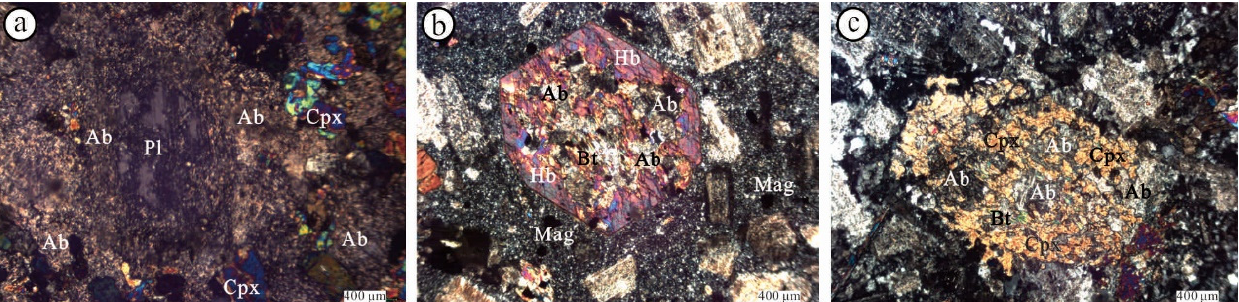
Figure 5. Petrographic features of plutonic rocks of the Jinling pluton. ( a ) Intensely albitized diorites show the replacement of plagioclase by albite. ( b , c ) Small albite and biotite grains have partially replaced hornblende and pyroxene resulting from alkali metasomatism. All photos were taken under crossed polarizers. Abbreviations: Ab = albite, Hb = hornblende, Bt = biotite, Cpx = clinopyroxene, Mag = magnetite, Pl = plagioclase .